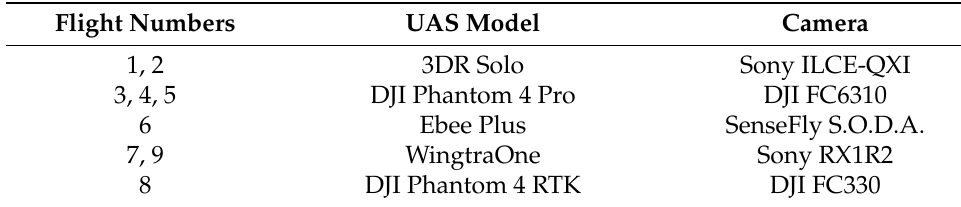
Table 1. UAS and Camera Used.